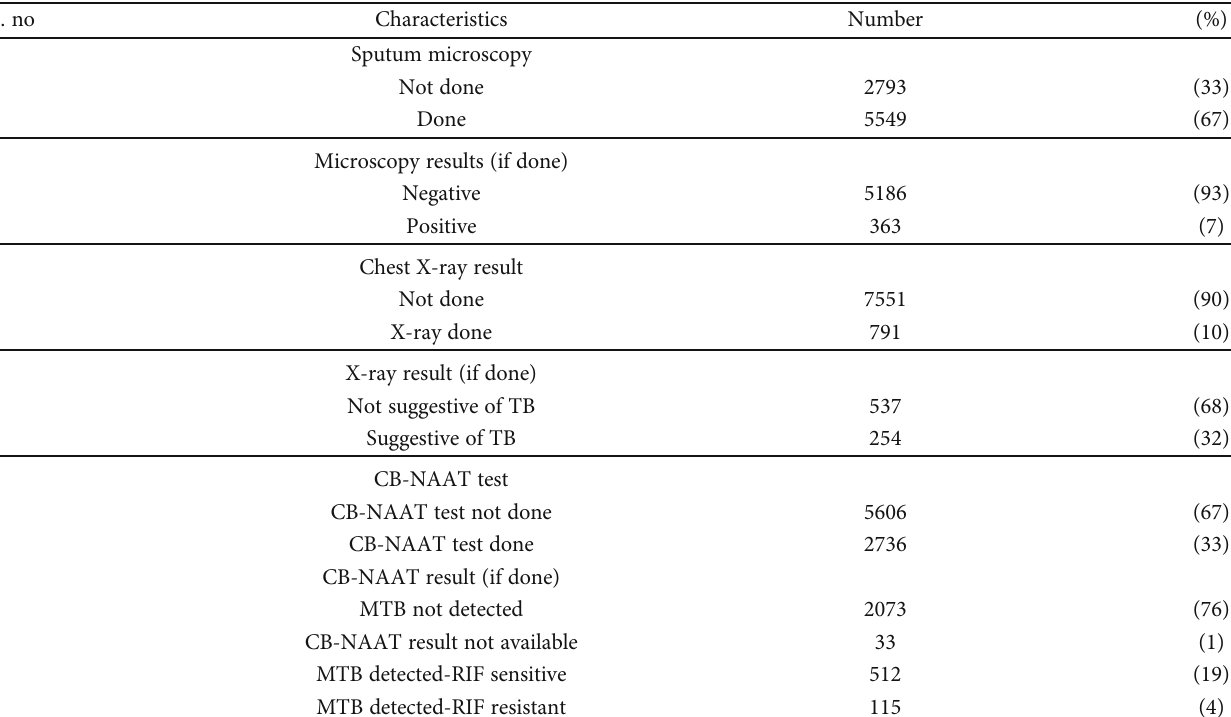
Table 5: Results of di ff erent TB diagnostic tests of Presumptive TB patients enrolled under RIPENED project, Telangana State, India, during 2018-19 ( N = 8342